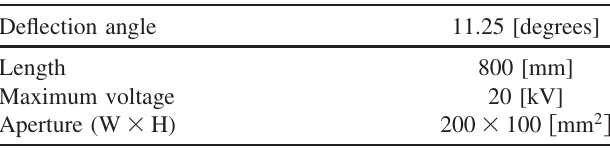
TABLE IV. Specifications of the injection kicker.